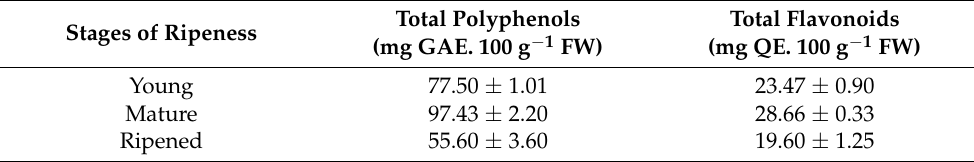
Table 1. Total polyphenols and flavonoids of C. moschata at three stages of ripeness. Stages of